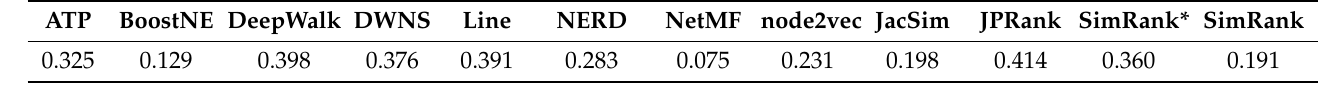
Figure 7. Accuracy of embedding methods and similarity measures with the Cora dataset. Table 6. Precision values with the Cora dataset.